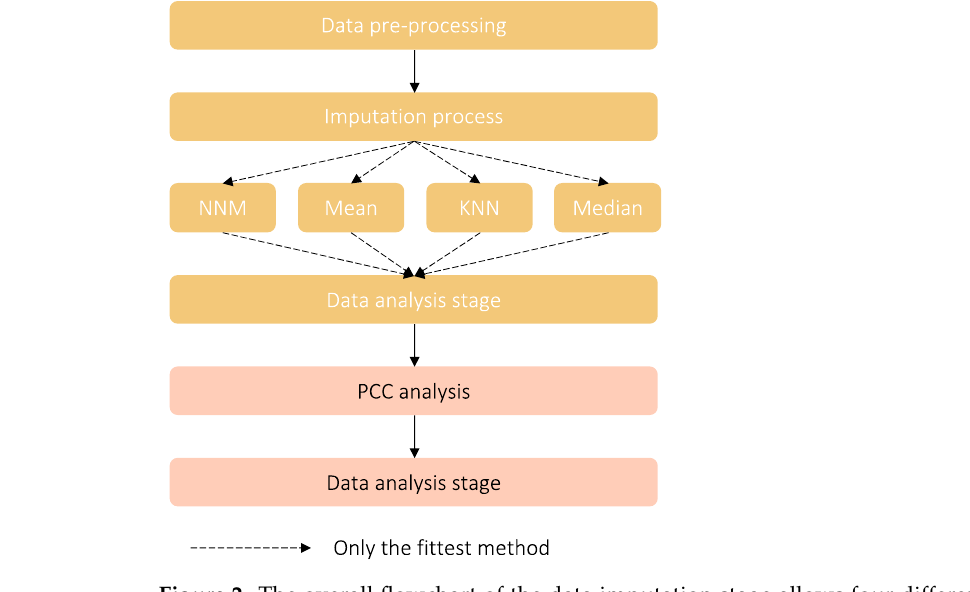
Figure 2. The overall flowchart of the data imputation stage allows four different options (KNN, NNM, Mean, Median) to calculate the most-fittest model.